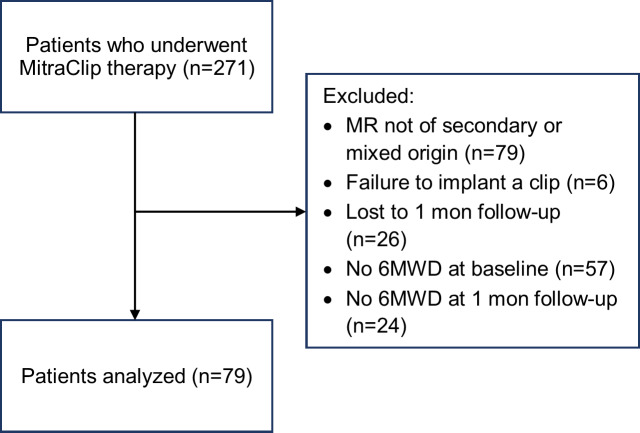
Flow chart depicting the inclusion process.Only patients who completed 6MWD at baseline and at the four weeks follow-up were included in the intent of a complete case analysis. mon, month; MR, mitral regurgitation; 6MWD, six-minute walk test.